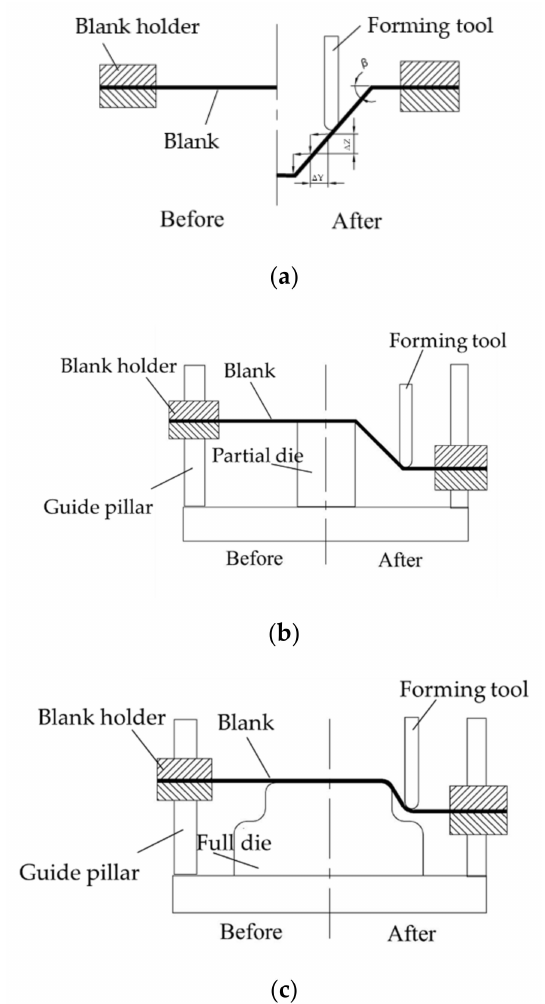
Figure 1. Schematics of incremental sheet forming (ISF): ( a ) single-point incremental forming (SPIF) (or negative incremental forming (NIF)); ( b ) two-point incremental forming (TPIF) (or positive incremental forming (PIF)) with a partial die; ( c ) TPIF (or PIF) with a full